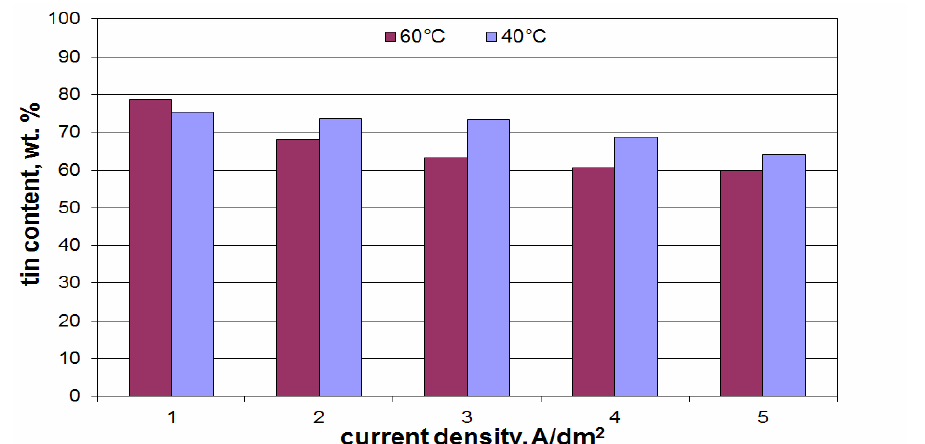
Figure 6 – Tin content in the Sn-Zn-layer depending on temperature and current density (electroplated from an electrolyte with 0.05 mol/l Sn; 0.1 mol/l Zn; 0.375 mol/l K4P2O7 and 1 g/l gelatine; pH = 9.3; Hull cell: 1A; 20 min.) Рис . 6 – Содержание олова в покрытии Sn-Zn, зависит от температуры и плотности тока ( электрохимическое осаждение из электролита 0.05 mol/l Sn; 0.1 mol/l Zn; 0.375 mol/l K4P2O7 с при применении 1g/l желатина ; pH = 9.3; ячейка Хулла : 1 A, 20 мин